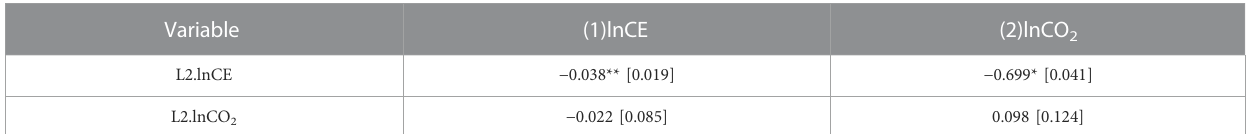
TABLE 7 GMM parameter estimation